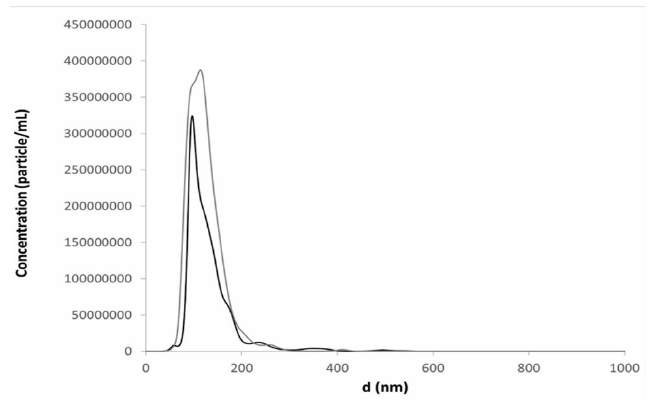
Figure 5. Particle size distribution from Nanoparticle Tracking Analysis (NTA) measurements of resuspended liposomes in the presence of trehalose (black line) and the combination of trehalose and PVP (grey line) after freeze-drying (method B) dispersions with 6% v/v ethanol content: This profile was obtained by plotting the average data obtained after analyses of 3 reconstituted liposome dispersions.